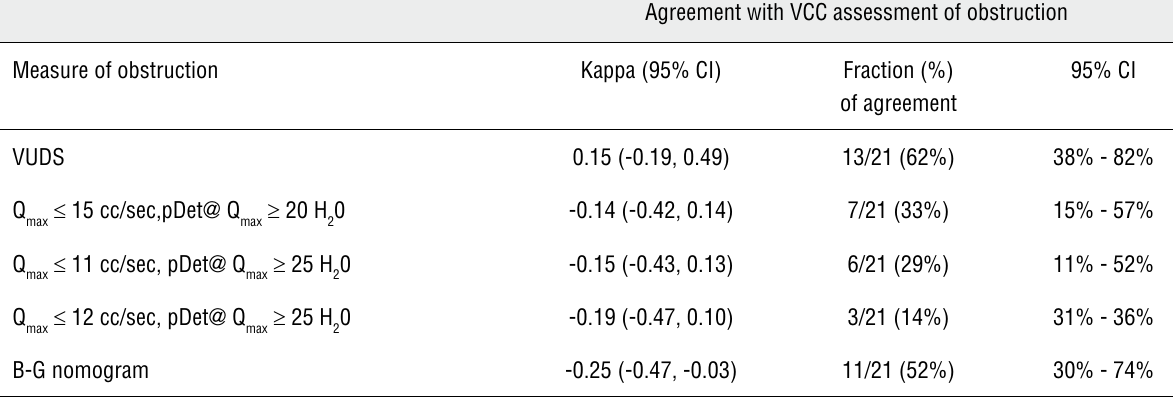
Table 2 - Agreement in assessment of bladder outlet obstruction between the VCC and five other